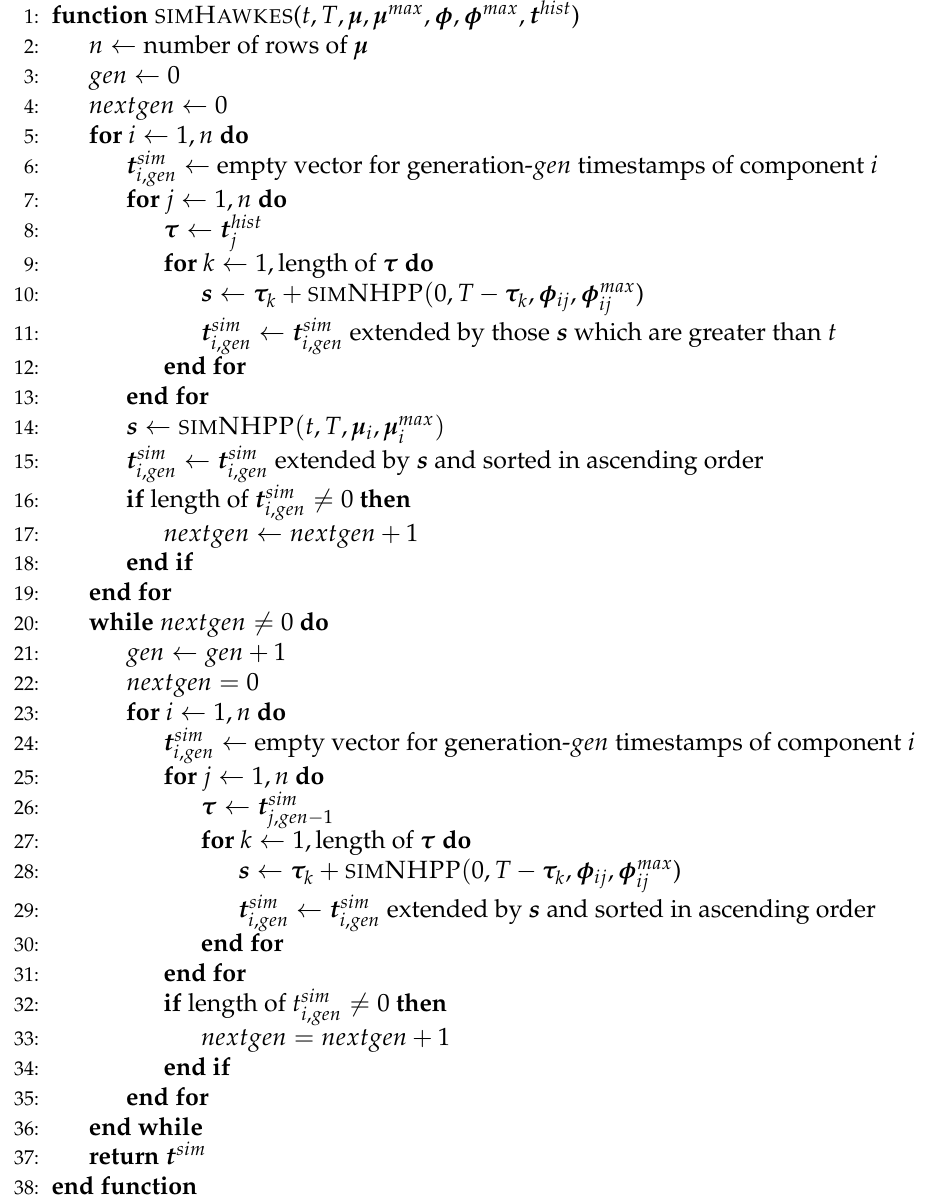
Algorithm A2 Hawkes